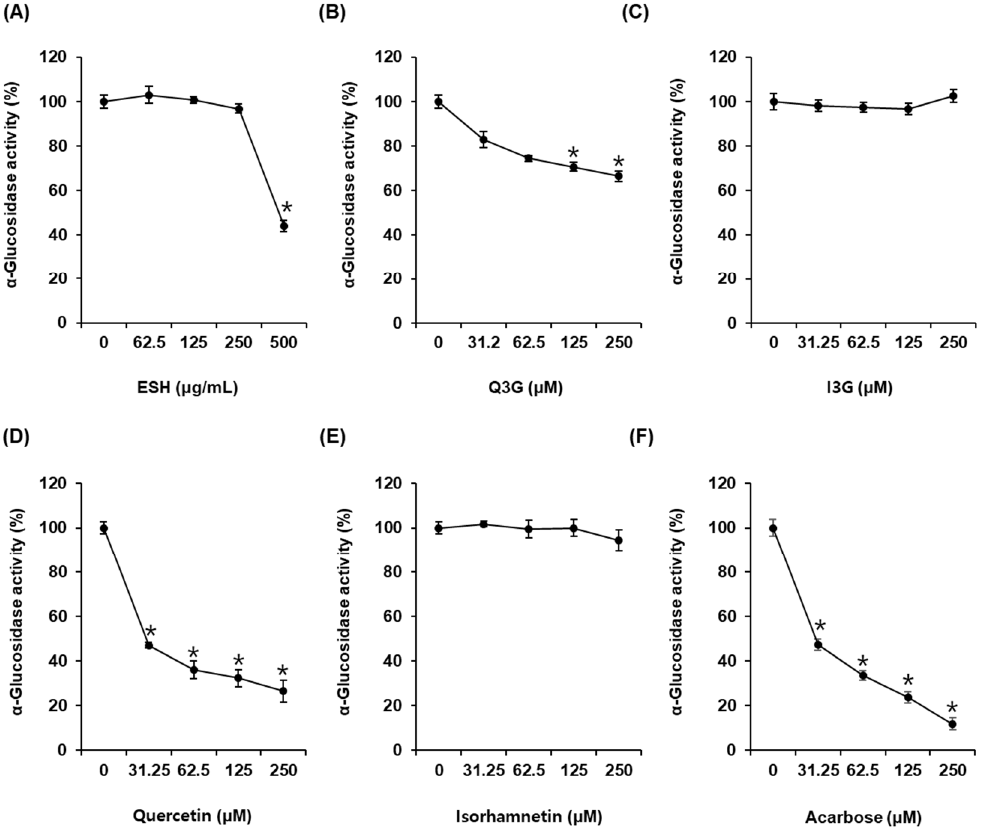
Figure 2. α-Glucosidase inhibitory activities of ( A ) ethanolic extract of Salicornia herbacea (ESH), ( B ) quercetin 3- O -glucoside (Q3G) ( C ) isorhamnetin 3- O -glucoside (I3G), ( D ) quercetin, ( E ) isorhamnetin, and ( F ) acarbose (positive control) compared with that of the control (0 μM) by α-glucosidase inhibitory activity assay ( n = 3 independent experiments, * p < 0.05, Kruskal–Wallis nonparametric test). Data are expressed as the mean ± SEM.